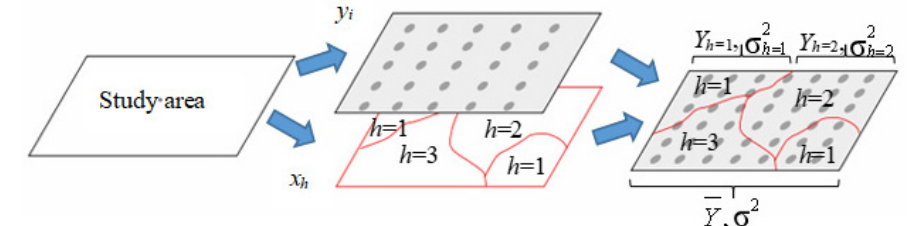
Table 2. Judgment basis of the interaction detector.